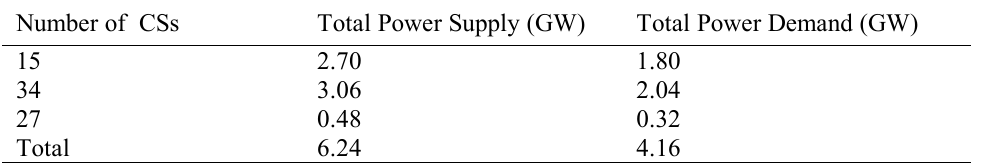
Table 18. Current condition of Iran CSs